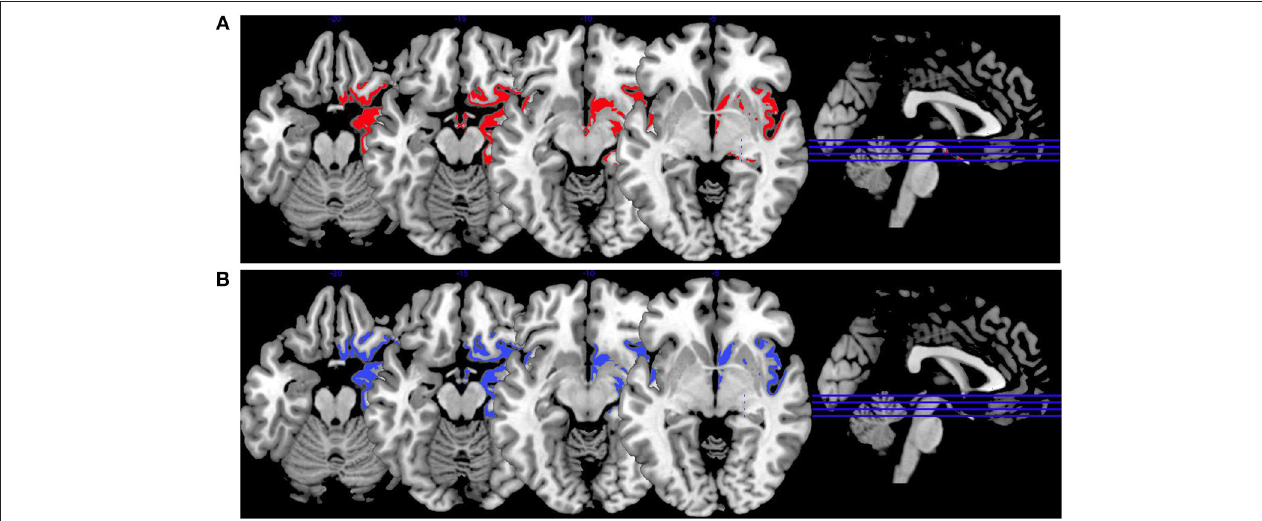
FIGURE 3 | Face affect recognition activations. Overview of the working memory brain activation patterns reported by the reviewed studies in the group comparison VS high vs. VS low. Hyperactivations are shown in red, hypoactivations in blue. (A) Shows the activation patterns in the group comparison VS high vs. VS low with VS high > VS low in red showing the contrast of neutral vs. disgustful faces, (B) shows the activation patterns in the group comparison VS high vs. VS low with VS high < VS low in blue showing the contrast of neutral vs. fearful faces. Shown slice numbers are 100, 110, 120, 130.